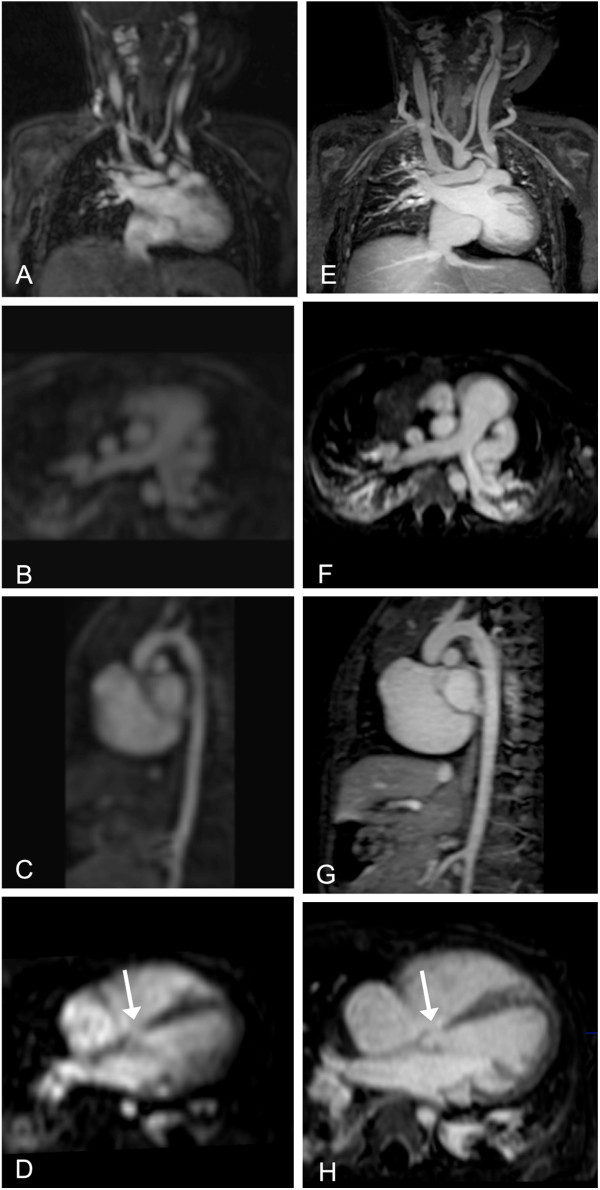
10-month-old patient with ventricular septal defect (arrow), persistent left superior vena cava, bilateral atelectasis and bovine arch. FP-MRA (A-D) and HR-MRA (E-H) in coronal (A,E), axial (B,F,D,H) and sagittal plane (C,G).